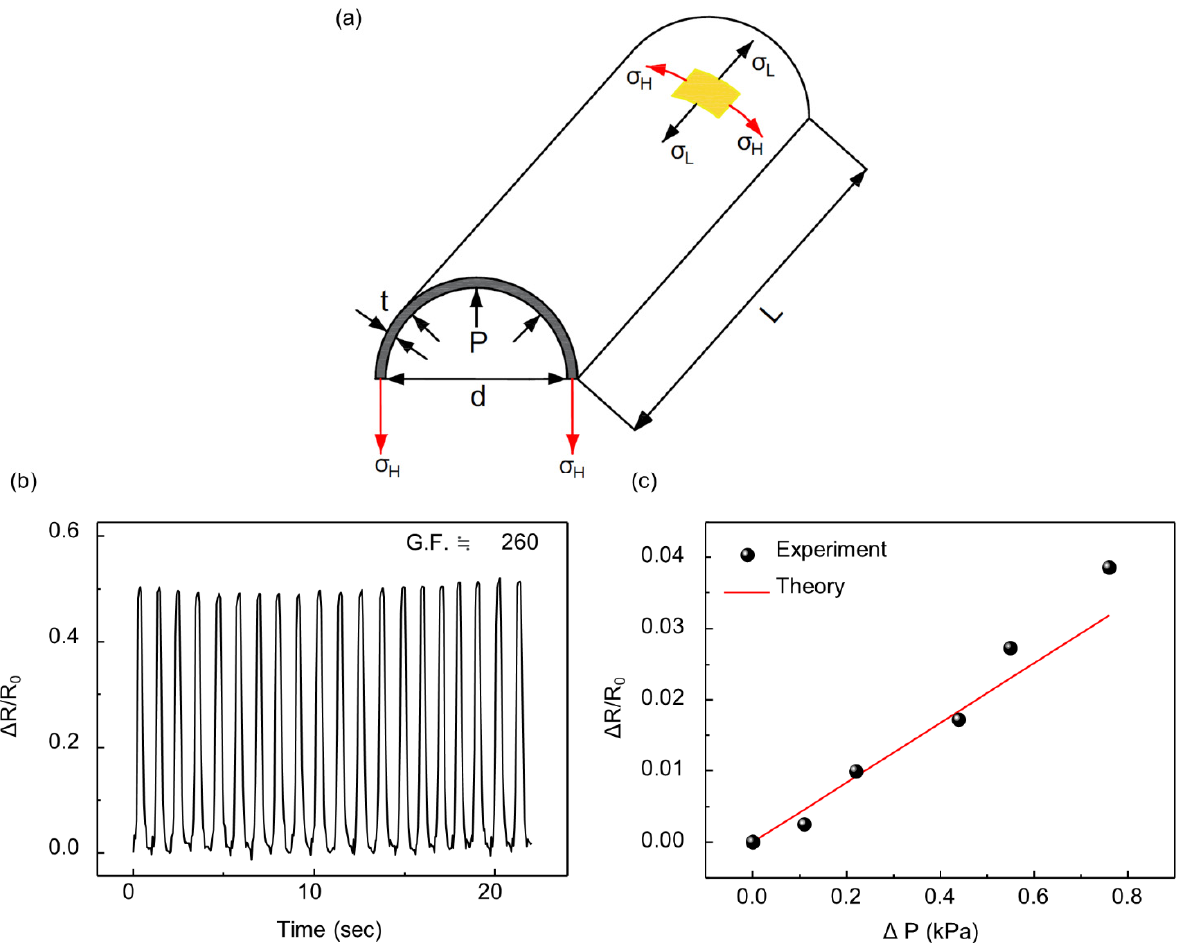
Figure 8. ( a ) Schematic design of the sensor indicating each parameter; ( b ) Relative changes in the resistance of the crack-based strain sensor under a tensile test; ( c ) Comparison between experimental (black dot) and theoretical data (red line).